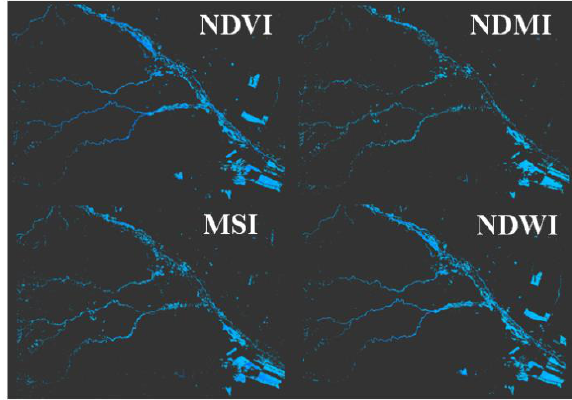
Figure 14. Comparison of flooded areas calculated from vegetation